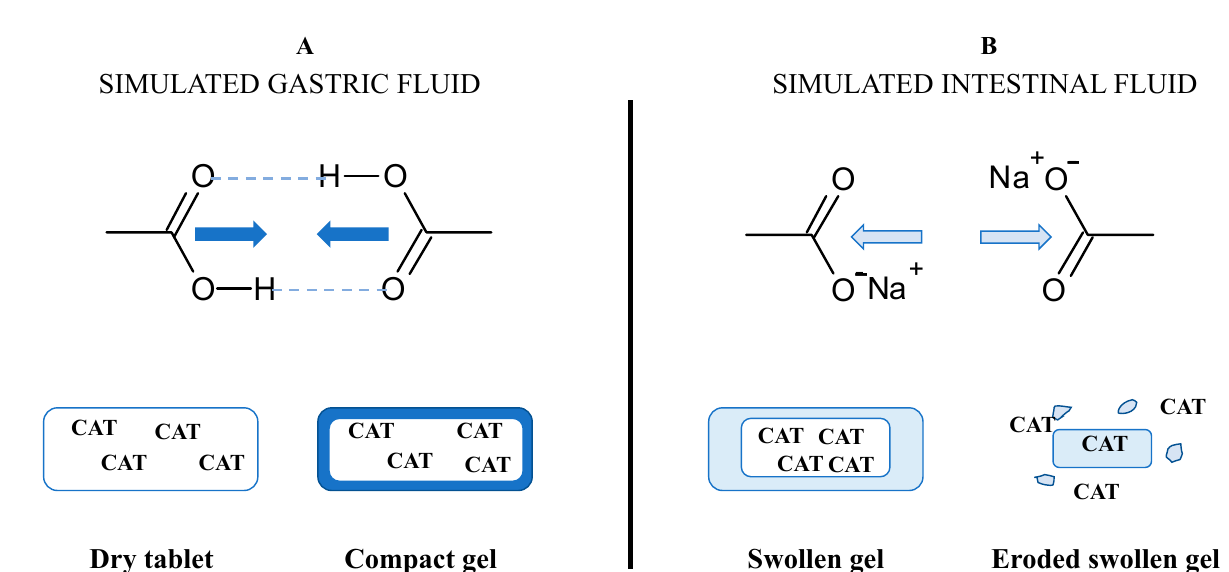
Figure 2. Concept of the formulation design of catalase (CAT) using excipients carrying carboxyl groups and the hypothetical mechanism of gastroprotection in ( A ) simulated gastric fluid (SGF) and of controlled release in ( B ) simulated intestinal fluid (SIF).